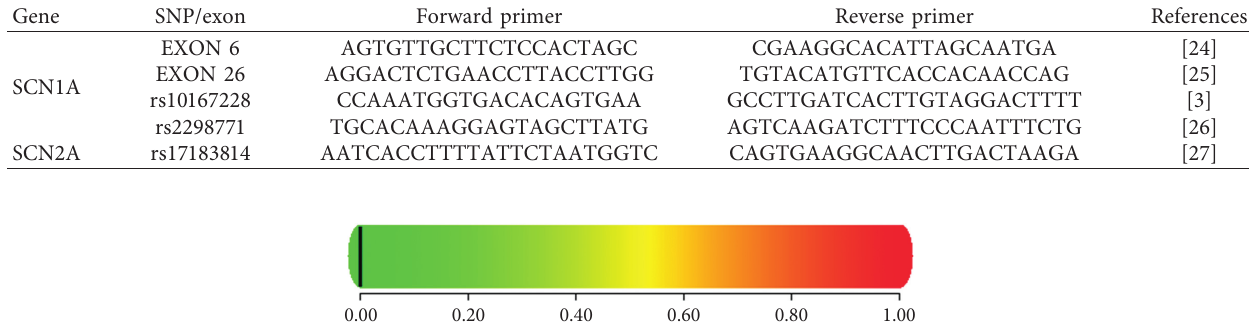
Figure 1: PolyPhen-2 prediction of rs2298771 of SCN1A. Table 2: Clinical data of the epilepsy patients.